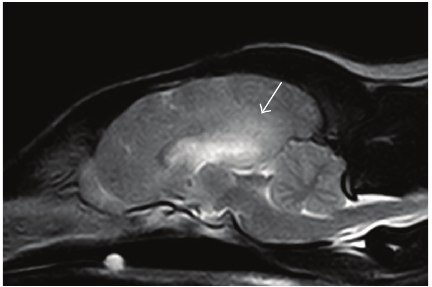
Figure 3: Sagittal T2-weighted image (TR = 3720 ms, TE = 90 ms, slice thickness = 3,5 mm). There is ill-defined T2 hyperintensity of the splenium of corpus callosum. No mass effect is